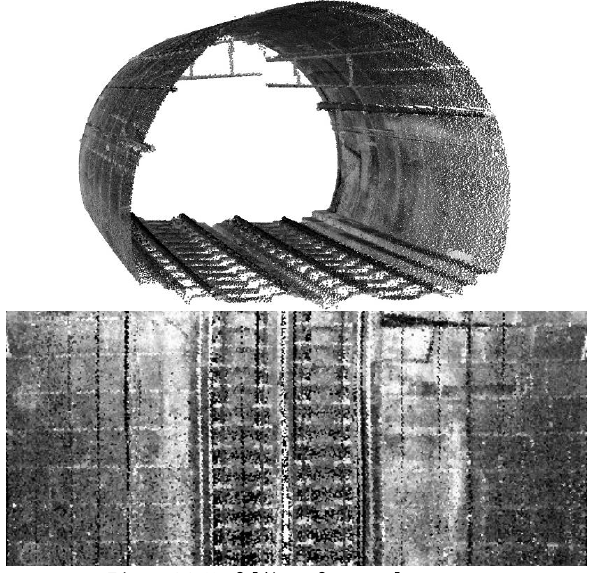
Figure 14. Unfolding of a tunnel